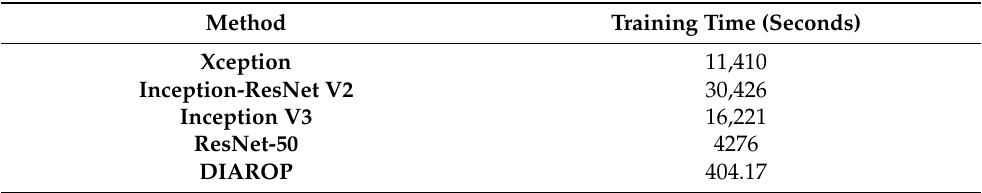
Table 8. The training execution time (sec) of the four CNNs and